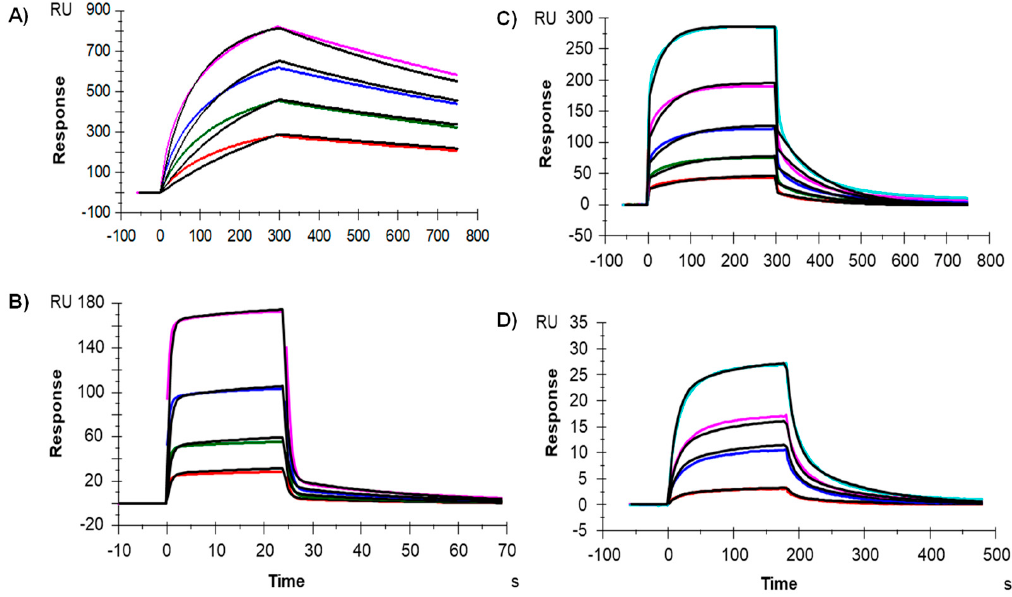
Figure 3. Binding of IgG-A7 to ( A ) Fc γ RIA, ( B ) Fc γ RIIA, ( C ) Fc γ RIIIA and ( D ) FcRn.